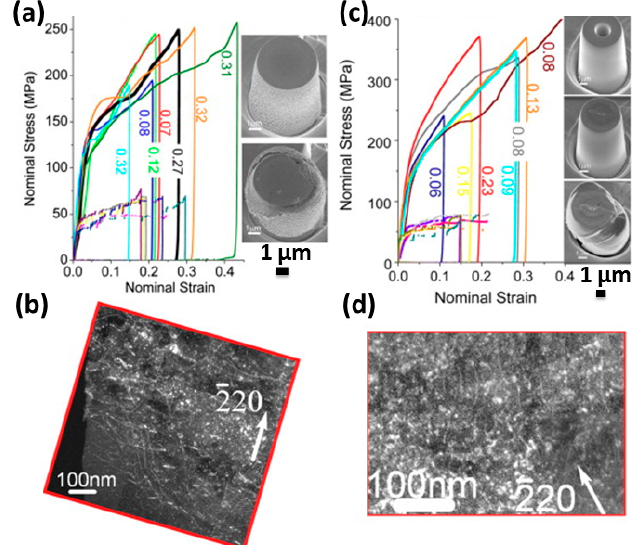
Figure 3. ( a ) Nominal stress vs. nominal strain for 6- μ m Al pillars coated with W of different volume fractions V W as numerically labeled and for monolithic Al pillars of a similar diameter (without numeric labeling). Insets show SEM images of the coated 6- μ m column corresponding to the blue stress-strain curve before and after compression. ( b ) Postmortem TEM image showing the trapped dislocations in the pillar with W coating. ( c ) Nominal stress vs. nominal strain for center-filled 6- μ m columns of different V W as labeled and for annular Al columns of a similar outer diameter (without numeric labeling). The three insets are SEM images of a 6- μ m center-filled pillar (corresponding to the brown-colored stress-strain curve) before filling, after filling and after compression, respectively. ( d ) Postmortem TEM image showing the trapped dislocations near the W filling [33] ( Reprinted from